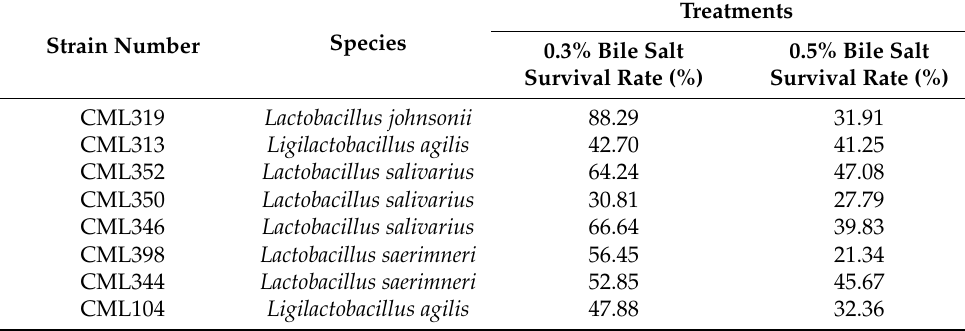
Table 5. Survival rate of different LAB strains under different bile salt concentrations.